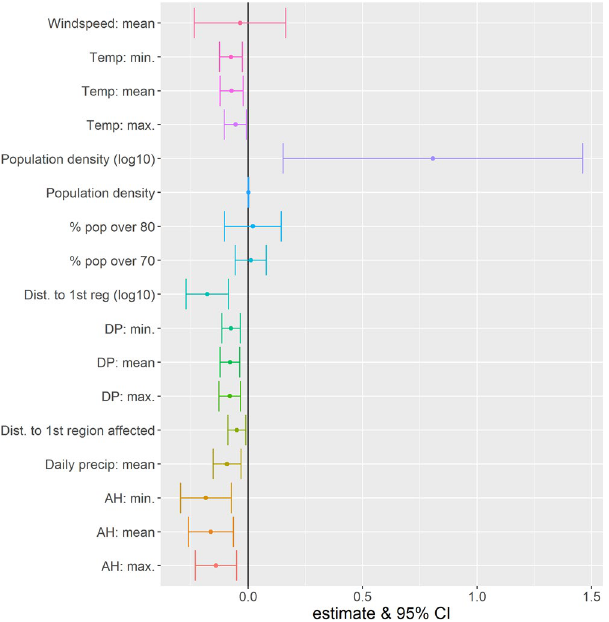
Figure 5. Change in R 0 on an additive scale estimated from the univariable model assuming a linear relationship between R 0 and the different variables over their entire